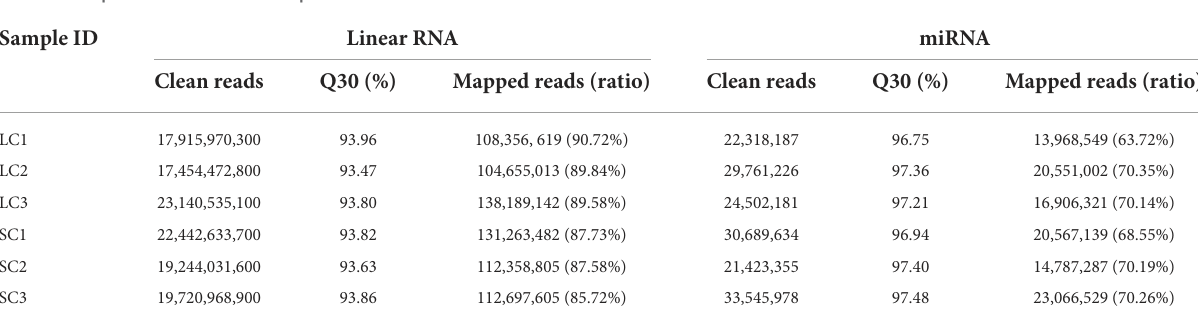
TABLE 1 Sequence results of six